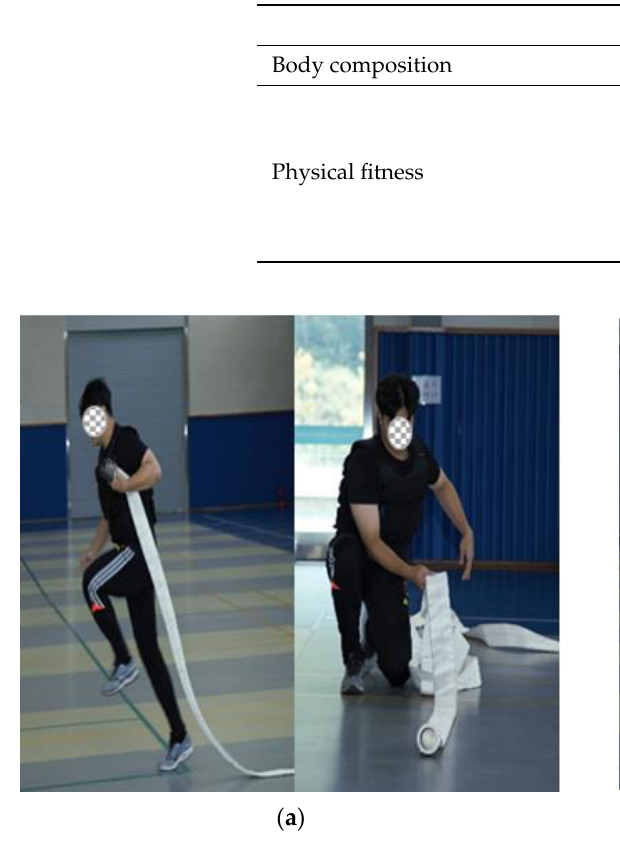
Table 3. List of measurement.